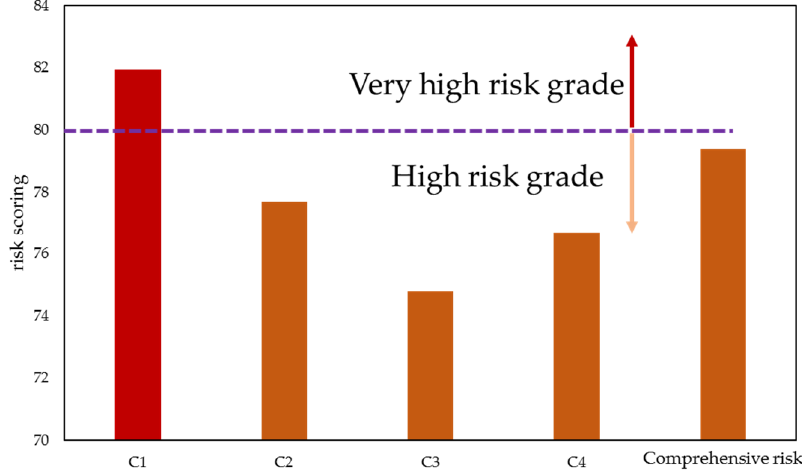
vague set evaluation matrix is obtained. When combined with the optimal weight of risk